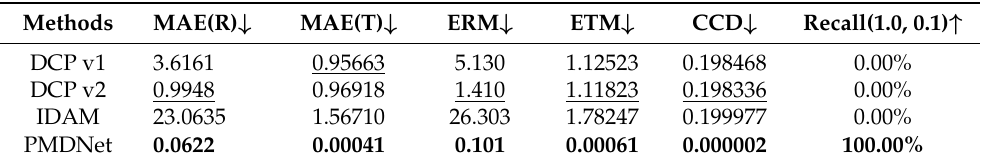
Table 10. Results on clean density-decreasing BIM scenarios. Bold and underline denote best and second best performance, respectively.